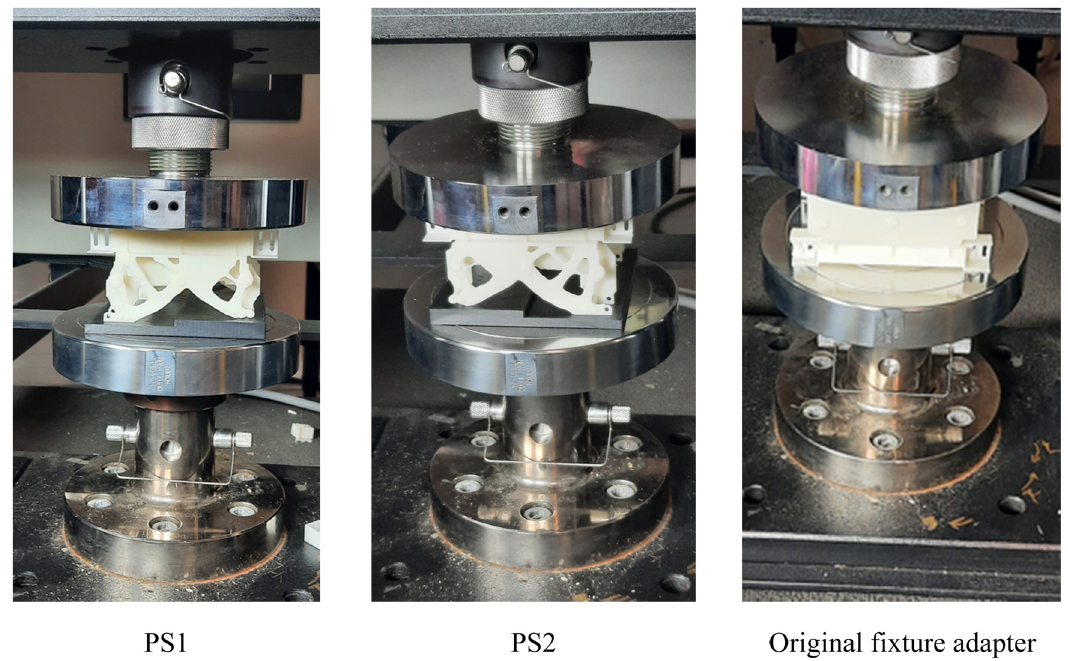
Figure 20: The simple compression testing setup on optimized and original fi xture adapter. A customized fi xture was used for optimized models to keep the structure as horizontal as possible during the